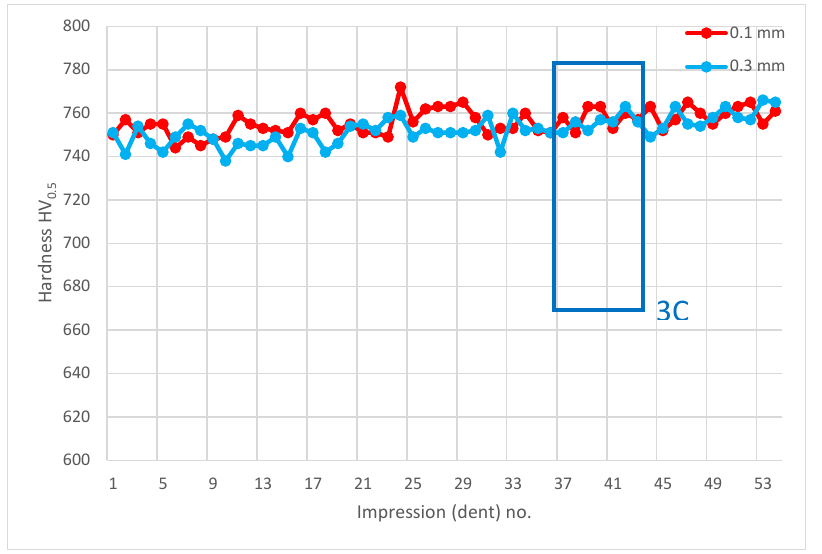
Figure 13. Pattern of hardness verification. Paths depth (distance from tooth surface): 0.1 mm and 0.3 mm. Cross-section G-G, zone: 3C.